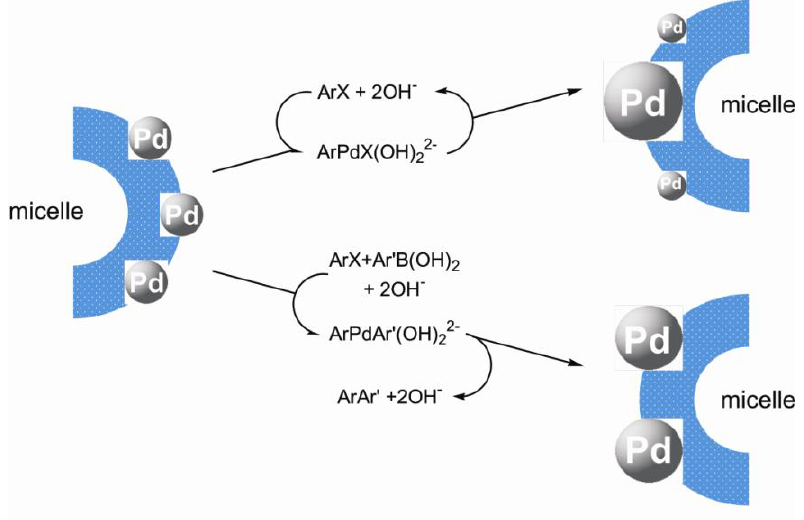
Figure 6. The prospective mechanism of Ostwald ripening of PdNPs at presence of ArX (at the left) and in the Suzuki-Miyaura reaction (at the